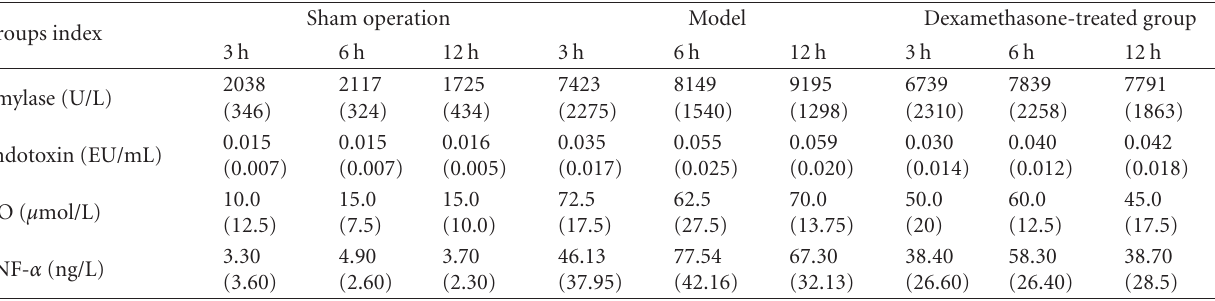
Table 2: Comparison of contents of di ff erent indexes in blood ( M ( Q R )).